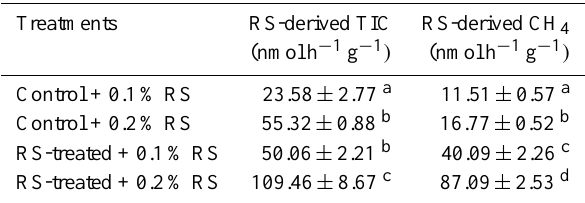
Table 2. Production rates of TIC and CH 4 derived from 0.1% or 0.2% 13 C-labeled RS applied after 40days of anoxic incubation of untreated control soil or RS-treated soil. For RS-treated soil, rice soil was amended with 0.5% unlabeled RS at the beginning of anoxic incubation. The headspace of all bottles was re-flushed with N 2 after addition of 13 C-labeled RS. This labeled RS was used as proxy of ROC in this experiment. Data are means ± SD ( n = 3). The differences in RS-derived TIC or CH 4 production rates among the treatments were examined using Duncan’s post hoc test of ANOVA. Different letters indicate significant difference ( P <0.05)